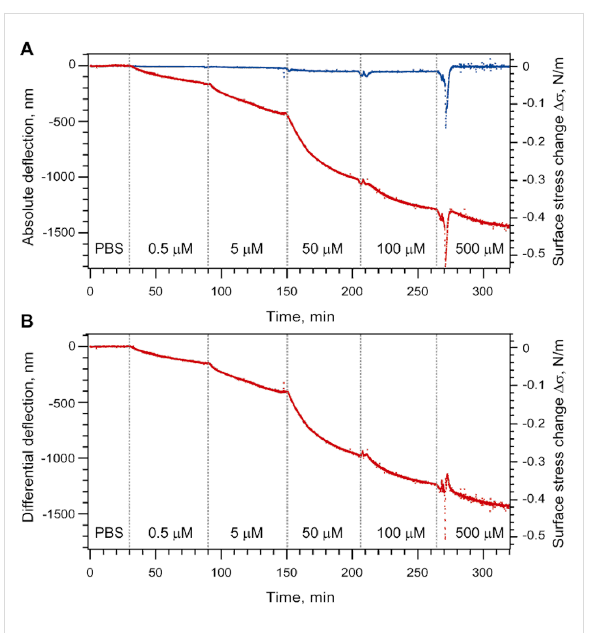
stress and an upward bending of the microcantilever describes tensile stress.